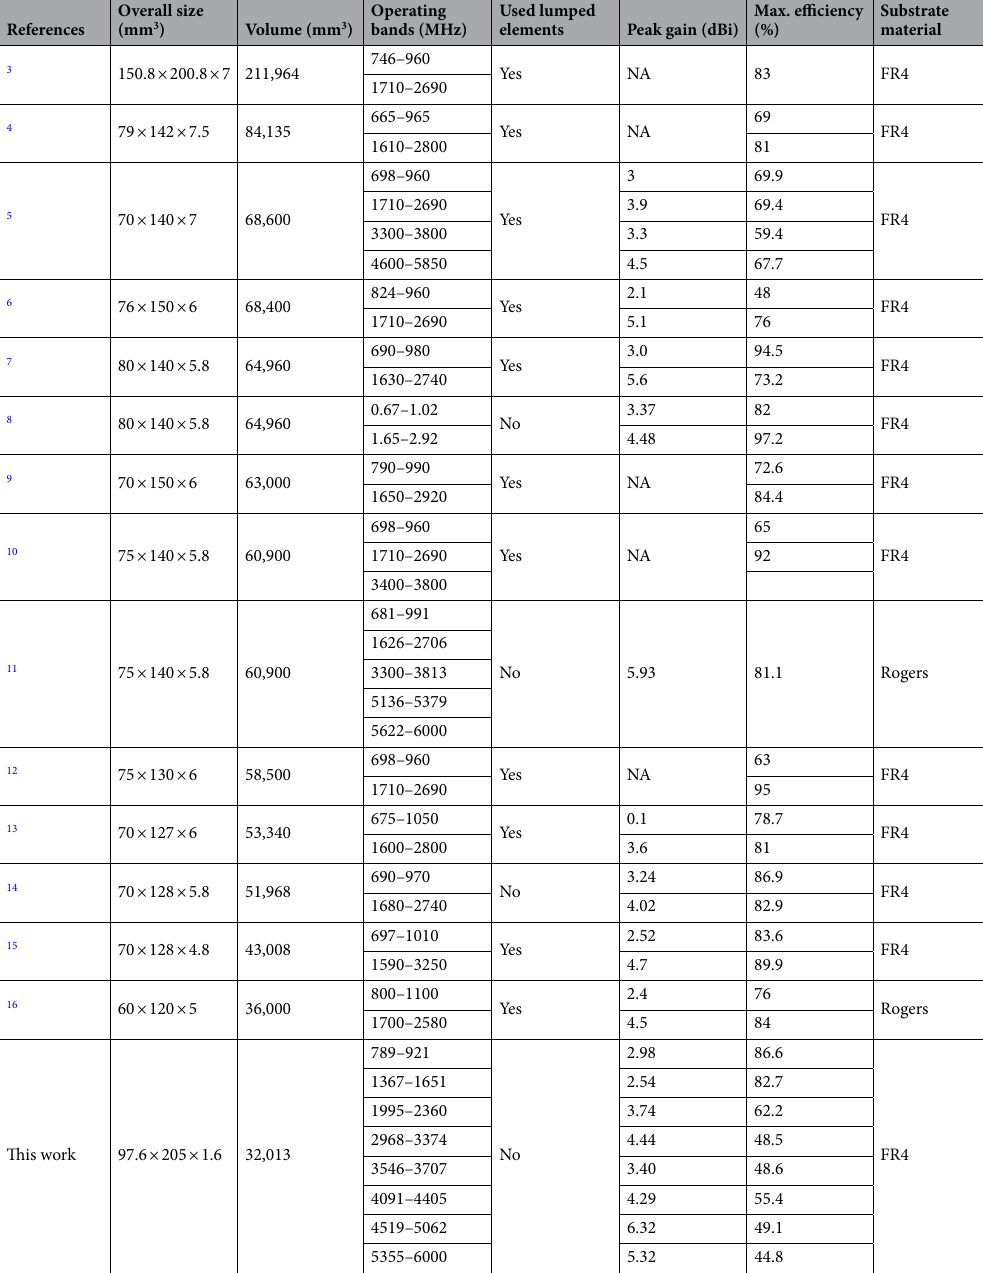
Table 1. Comparative study of the few existing multi-band antennas with the proposed